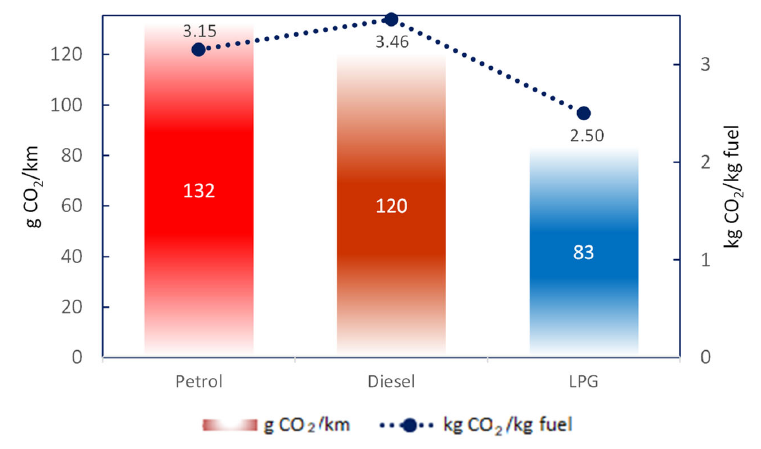
Figure 2. Approximate CO 2 emissions of different fossil fuels.